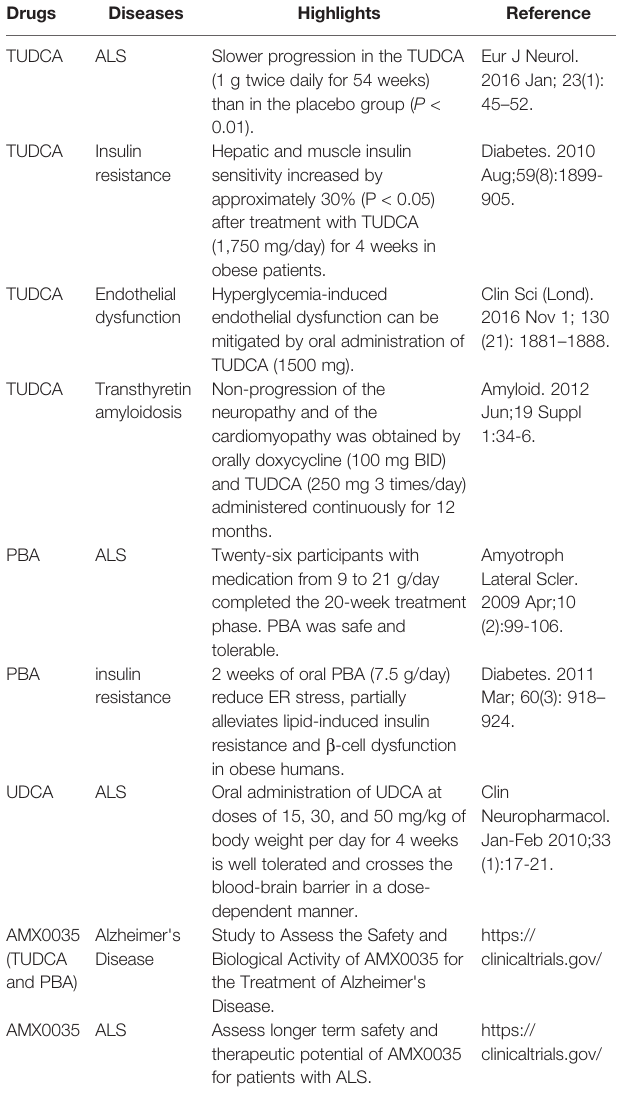
TABLE 1 | Overview of clinical trials using pharmacological